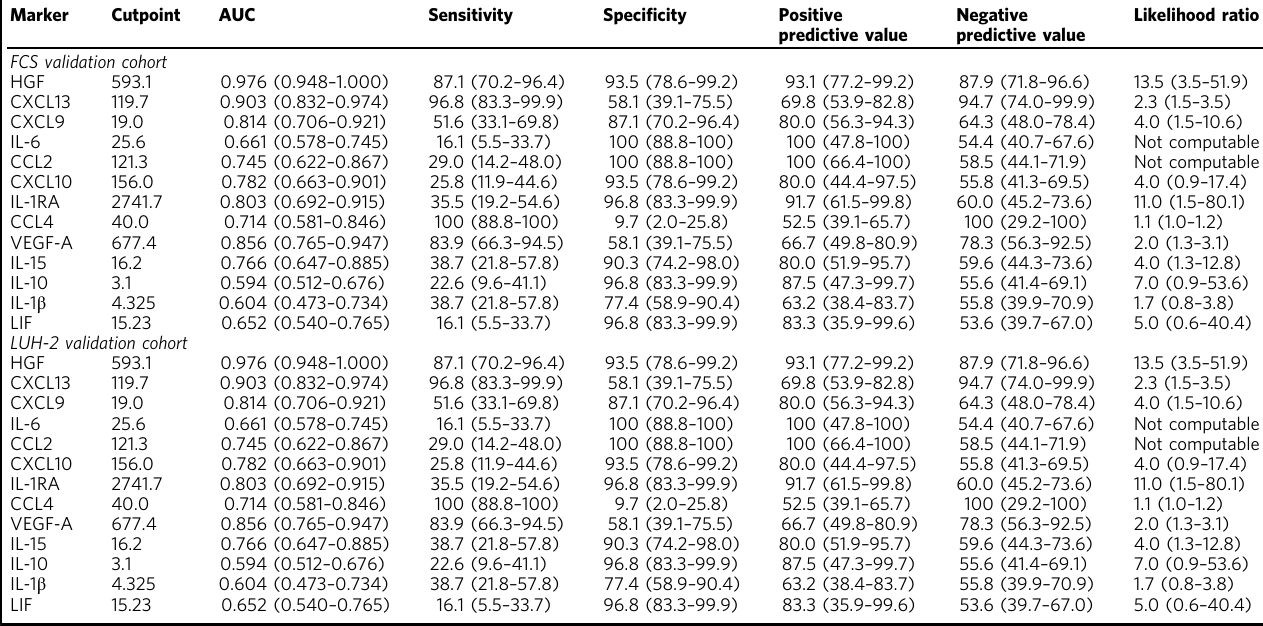
Table 2 Performance (AUC, sensitivity, speci fi city, positive and negative predictive values, and likelihood ratio) of each candidate markers dichotomized into lower than, higher or equal to the cutpoint distinguishing ICU and non-ICU COVID-19 patients in FCS and LUH-2 validation cohorts.